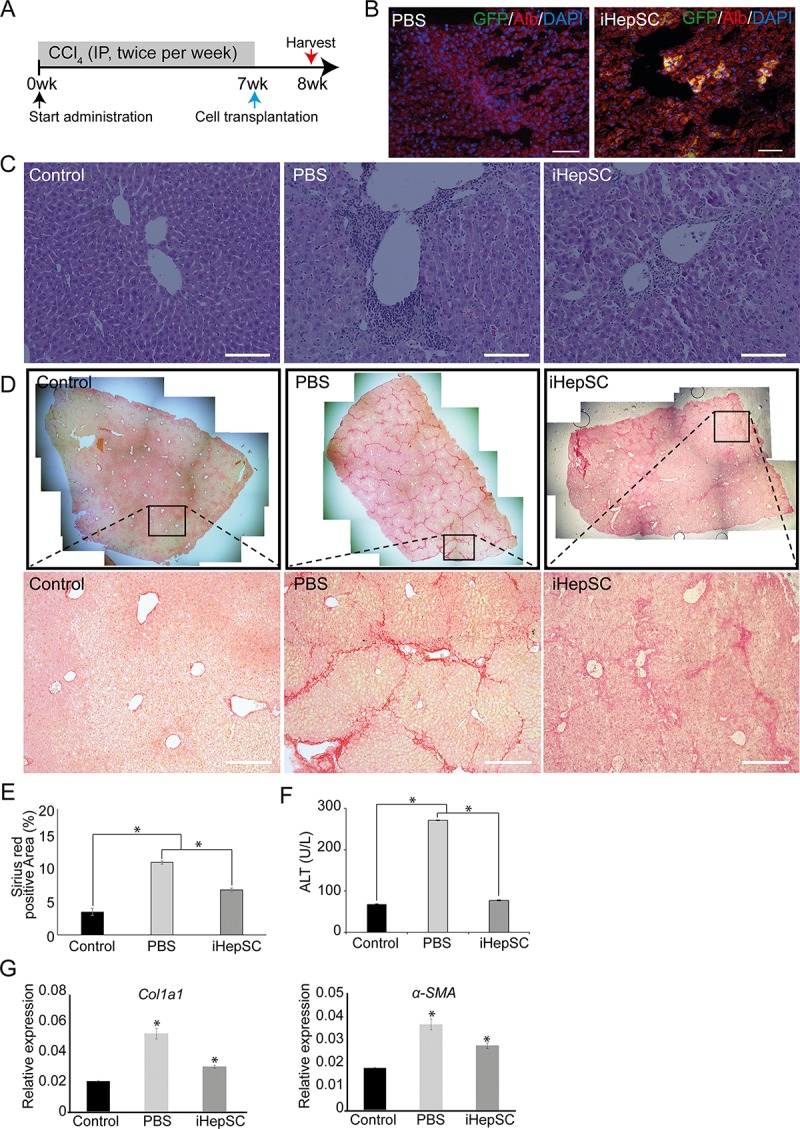
Therapeutic effects of transplanted iHepSCs in CCl4-induced chronic liver fibrosis model.(A) Scheme for in vivo experiment. (B) Immunofluorescence images of GFP-labeled iHepSCs in liver sections of the mice. The yellow area represents the successful engraftment of iHepSCs into the liver through the spleen (4.07 ± 0.33%). The nucleus was stained with DAPI. Scale bar: 150 μm. (C-D) Images of H&E and Sirius red staining for liver sections of fibrosis mice model. The black box enlarged in below. Scale bar: 150 μm. (E) Quantification of the fibrotic area (%) of liver isolated from (D). Sirius red staining shows collagen deposition of liver. Fibrous positive area (%) was analyzed by using software image J 1.51J. *, P<0.05. (F) Serum levels of alanine aminotransferase (ALT) (n = 9). *, P<0.05. (G) Gene expression analysis of fibrotic genes (Alpha-1 type 1 collagen: Col1a1; alpha-smooth muscle actin: α-SMA) in the liver tissues by qPCR. The transcriptional levels were normalized by the housekeeping gene (Gapdh). Error bars indicated standard errors from triplicate samples (n = 3). *, P<0.05.